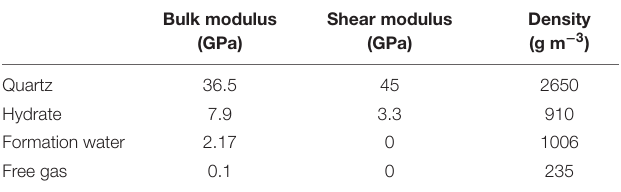
TABLE 1 | Properties of the sediment constituents.